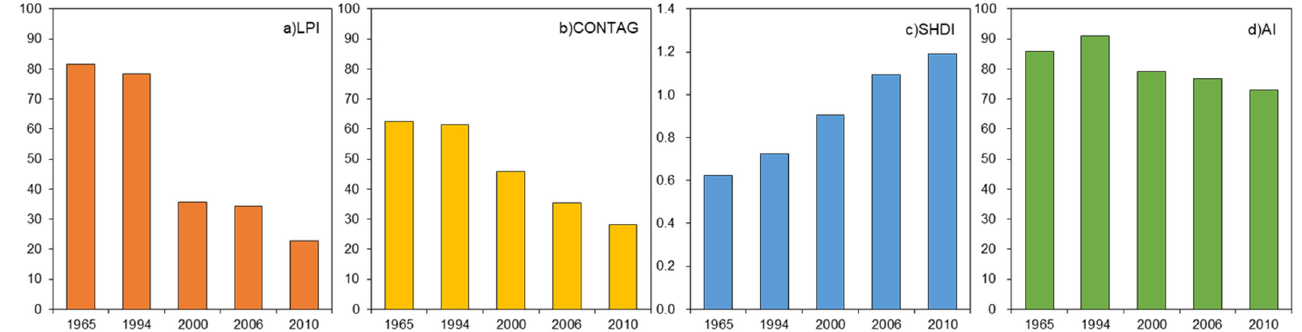
Figure 4. The landscape metrics of impervious surfaces at the landscape level (1965–2010). ( a ) LPI decreased year by year from 82 to 23; ( b ) CONTANG decreased year by year from 22 to 28; ( c ) SHDI increased year by year from 0.6 to 1.2; ( d ) AI decreased year by year from 86 to 73.